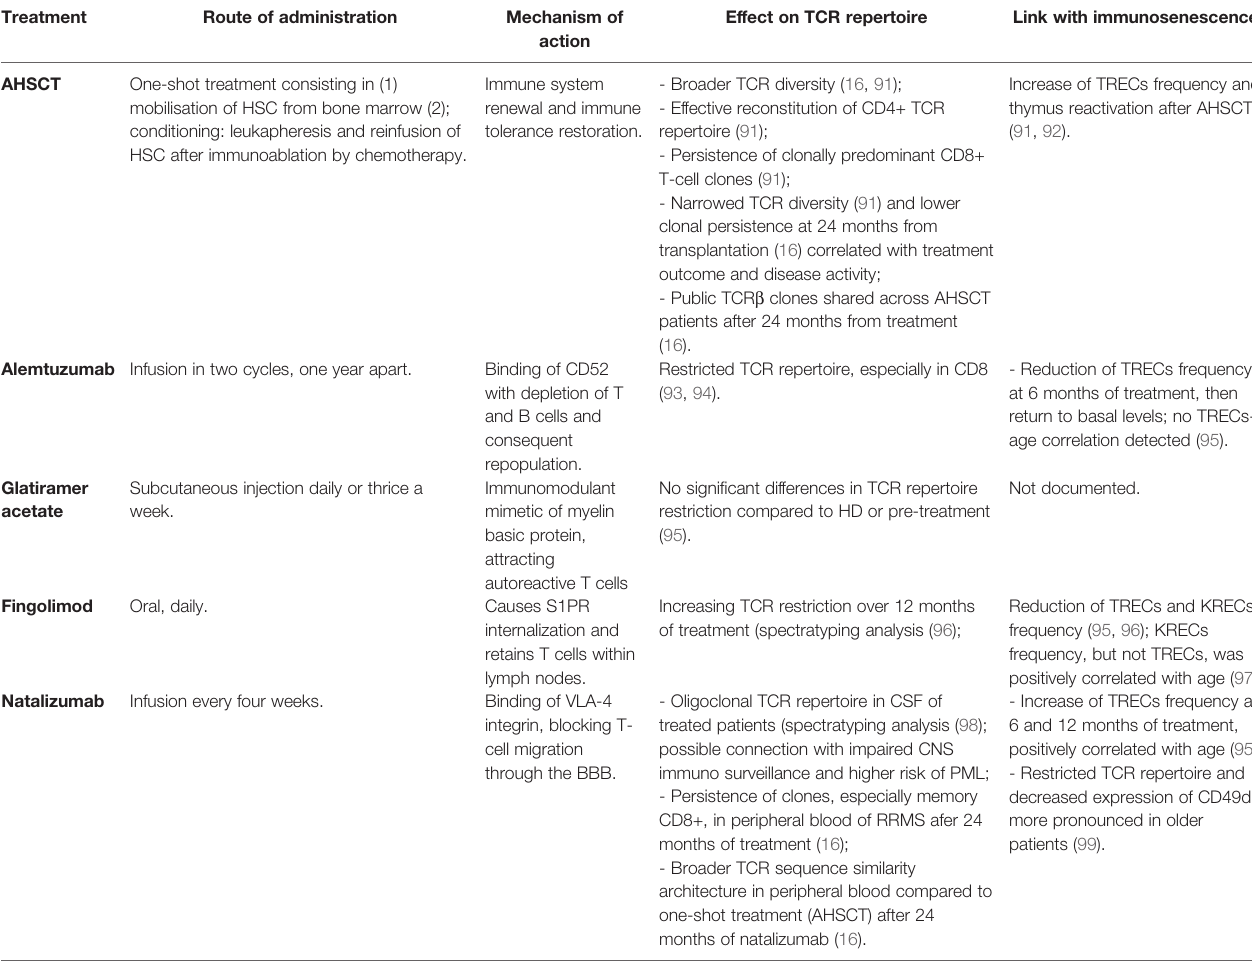
TABLE 1 | Disease-modifying treatments, TCR repertoire and immunosenescence in Multiple Sclerosis.